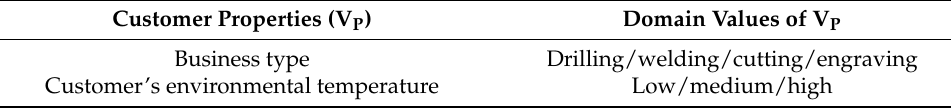
Table 4. Examples of customer’s business environment variables.